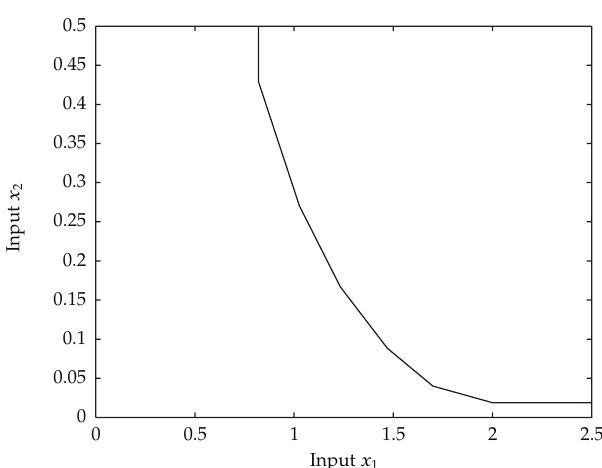
Figure 16: Input isoquant CRS at y (cid:9) 1, enlarged in the interval (cid:6) 2 , 5;0 , 5 (cid:7) .